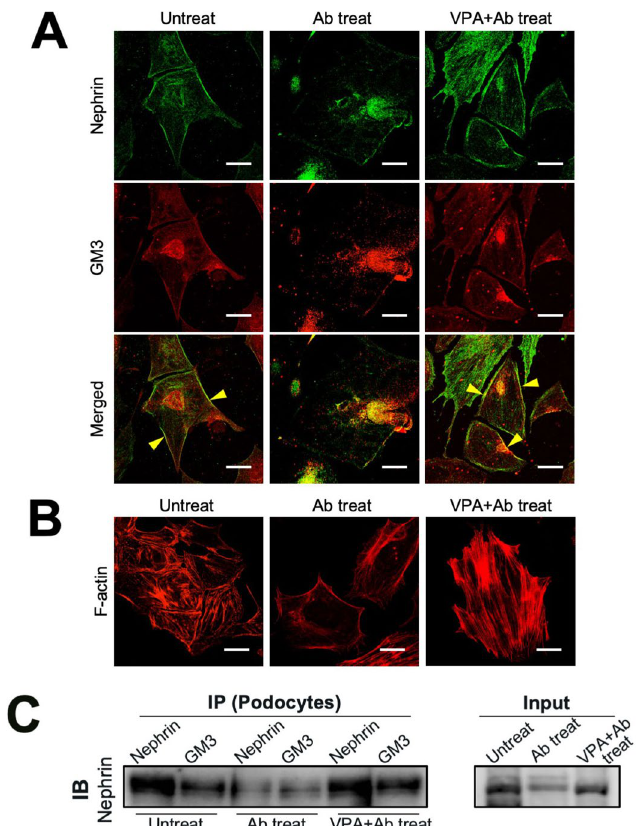
Figure 5. Effect of anti-nephrin antibody and VPA on podocytes and interaction of nephrin and GM3. ( A ) Immunofluorescence staining images of nephrin (green) and GM3 (ref) in various treated podocytes. Yellow arrowheads showing merged areas of nephrin (green) and GM3 (red). ( B ) Immunofluorescence staining images of F-actin (red) in the same treated cells as A. Scale bars: 10 µm. Untreated (Untreat), anti-Nphs Ab treated (Ab treat), preVPA + anti-Nphs Ab treated (VPA + Ab treat) podocytes. ( C ) Immunoprecipitation (IP) using cell lysate of various treated podocytes and anti-nephrin and GM3 antibodies, and immunoblot (IB) analysis using anti-Nphs antibody. Cell lysate of untreated (Untreat), anti-Nphs Ab treated (Ab treat), preVPA + anti-Nphs Ab treated (VPA + Ab treat)